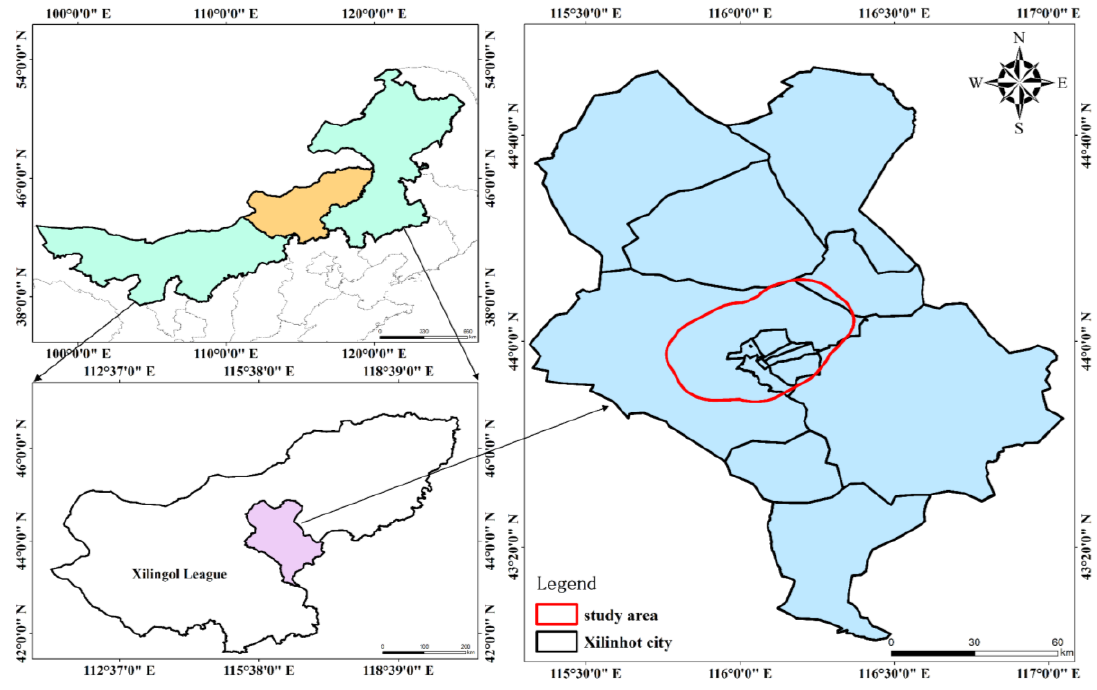
Figure 1. Map of the study area.